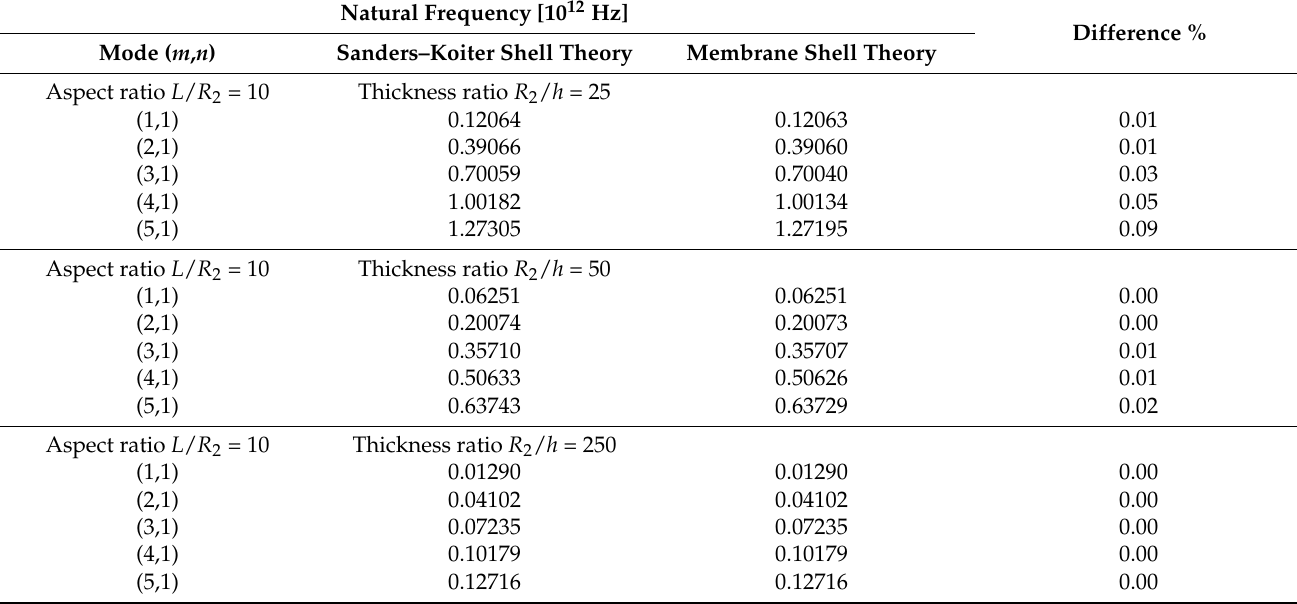
Table 9. Simply supported DWCNT with aspect ratio L / R 2 = 10 and thickness ratios R 2 / h = (25,50,250). Beam-like vibration modes ( n = 1). Comparisons between Sanders–Koiter and membrane shell